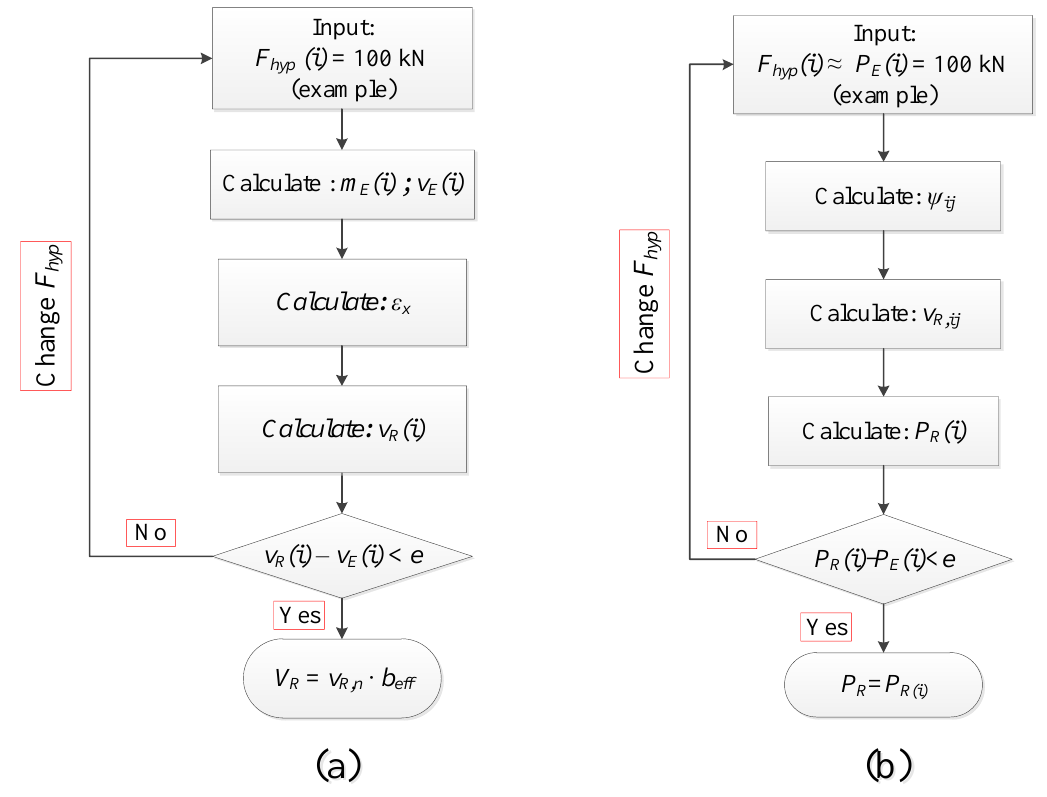
Figure 4. Flowchart of calculations for ( a ) one-way shear resistance predictions and ( b ) punching shear capacity with the fib Model Code 2010 expressions in the comparisons between tested and predicted resistances.